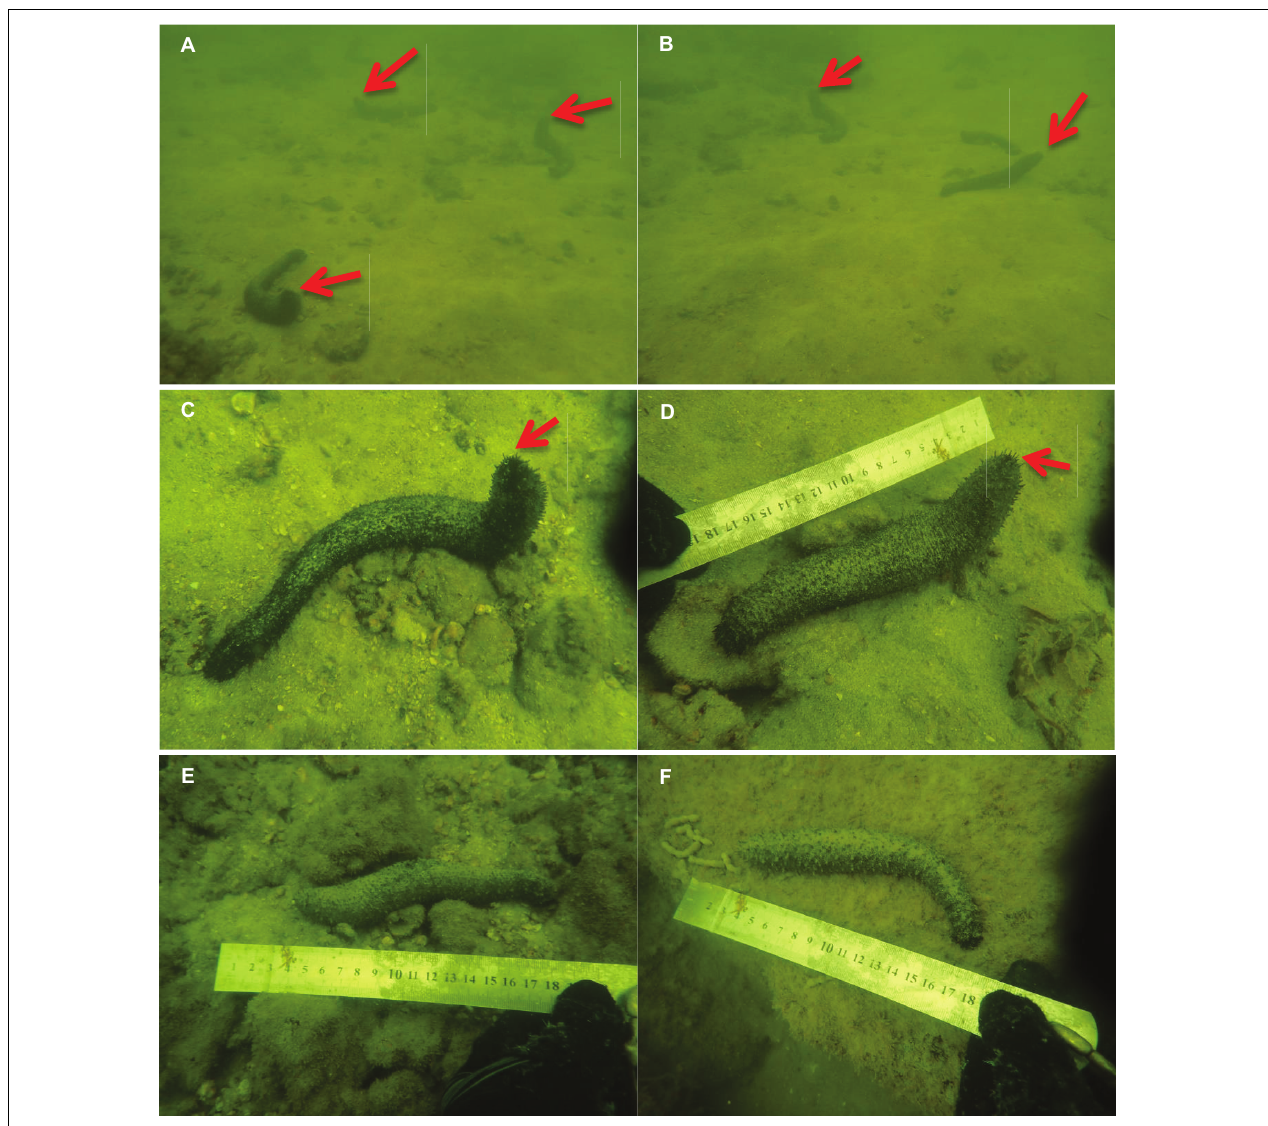
FIGURE 5 | Sea cucumber Holothuria leucospilota at S2 in summer 2017: (A–D) DS 30–50 m, with arrows indicating anus; (E,F) DS 0–20